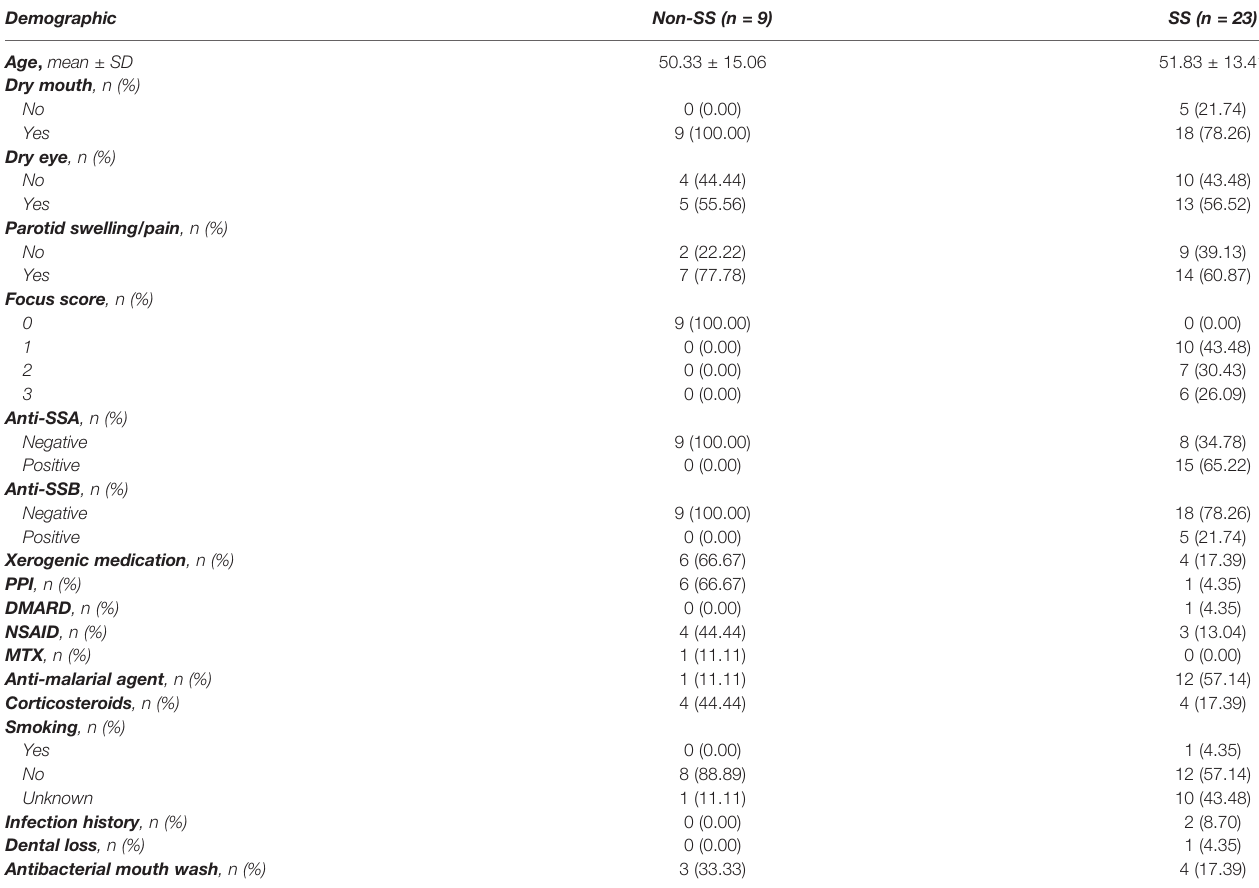
TABLE 1 | Patient characteristics of the study